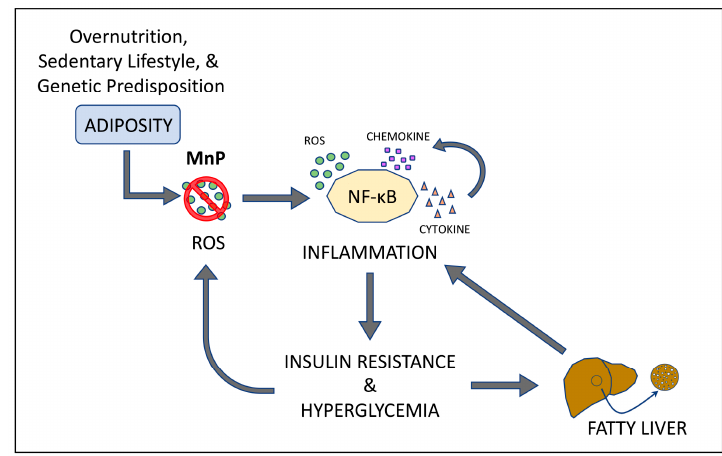
Figure 9. Mechanism of redox modulation by MnP in a HFD model of obesity and insulin resistance.